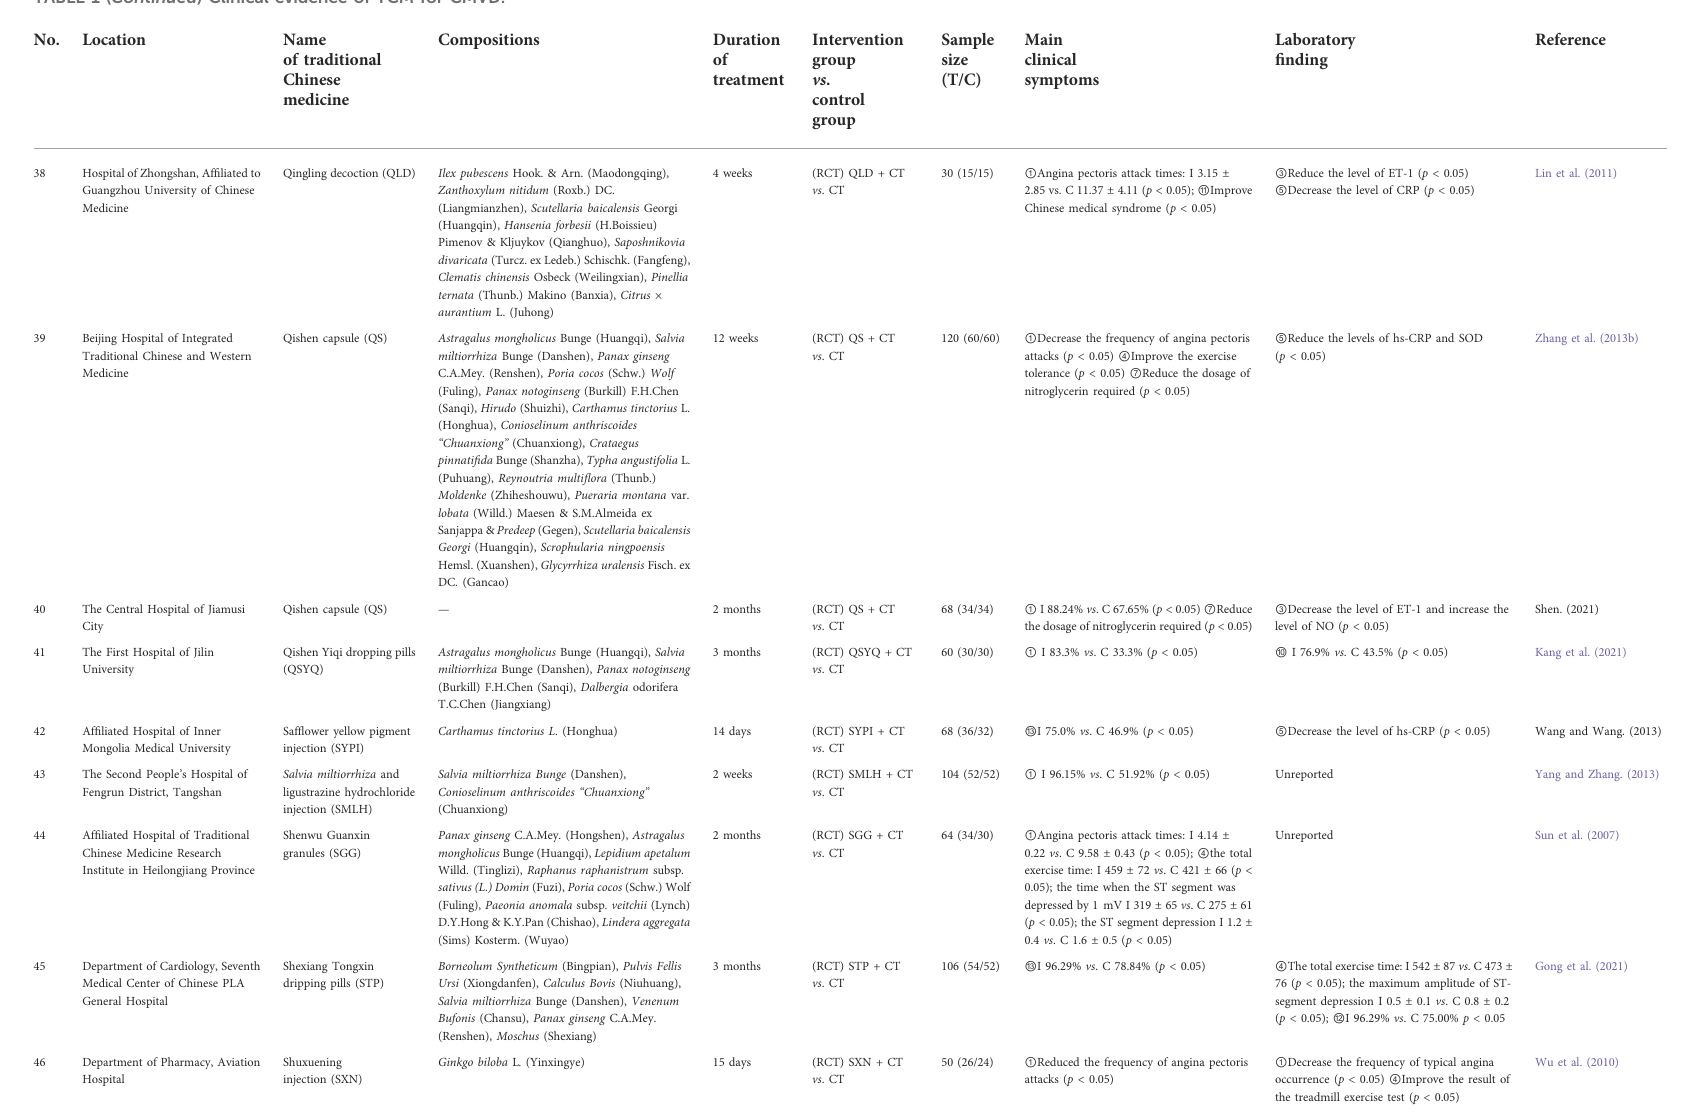
TABLE 1 ( Continued ) Clinical evidence of TCM for